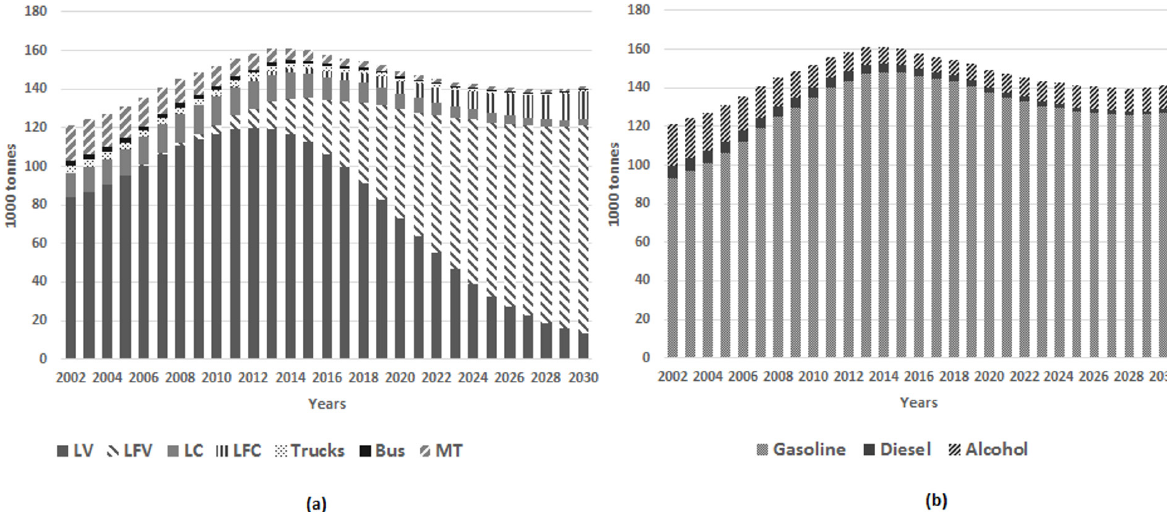
3 - Emission scenarios of CO in the MRPA (associated with the pessimistic estimation of the fleet) for the period between 2002 and 2030. ( a ) Scenarios by vehicles categories. ( b ) Scenarios by type of